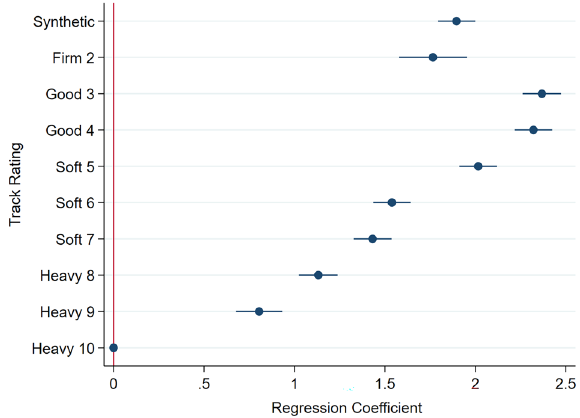
Figure 3. Coefficient plot (regression coefficients and associated 95% confidence intervals) showing the proportional effect of track surface type and rating (synthetic vs turf tracks rated from firmest to softest) on the percentage of fatigue life accrued over Thoroughbred race starts in Tasmania, Australia, according to estimated joint loads scaled to a maximum of 90